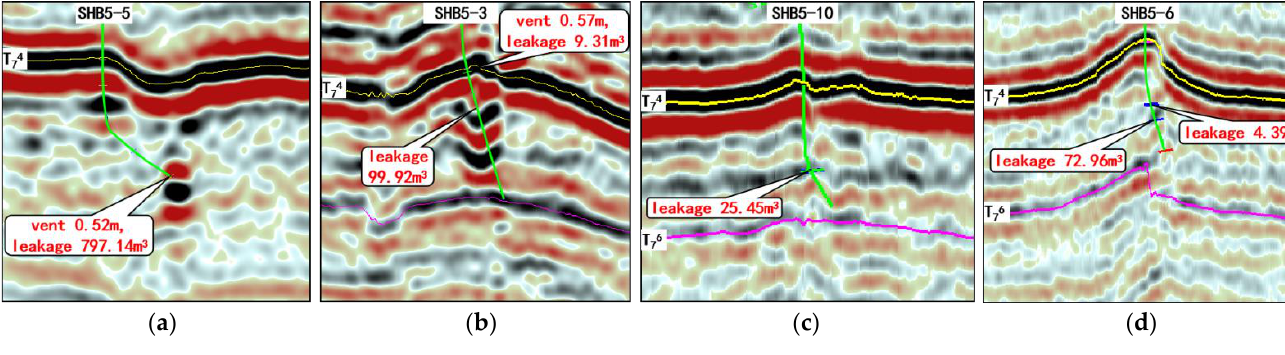
Figure 5. Different types of seismic reflection characteristics of the inner reservoir. The black box indicates the location and data of drilling venting and leakage in the seismic profile. ( a ) Standard beads: the ratio of major axis to minor axis on the plane and section is close to 1, nearly circular; ( b ) Non-standard beads: irregular amplitude abnormal reflection with non-circular shape; ( c ) Linear weak reflection; ( d ) Random reflection.